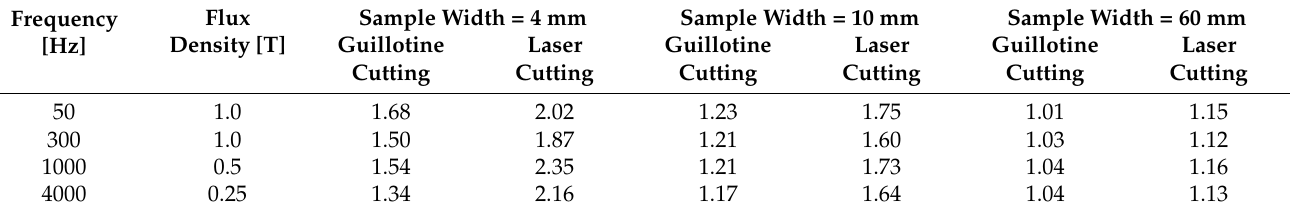
Table 7. Comparison of the relative (referred to measured loss values of water-cut sample 60 mm